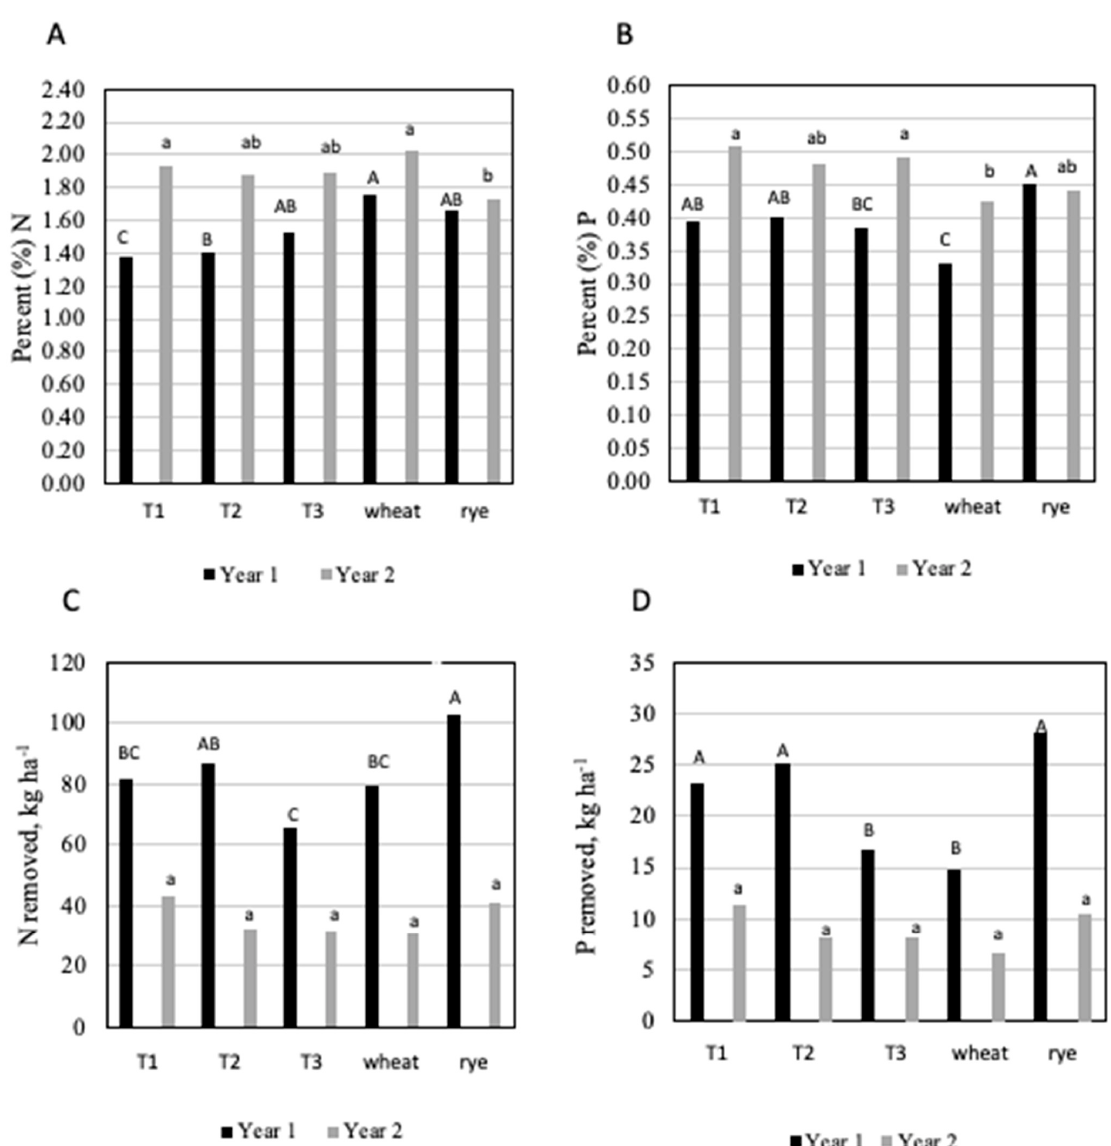
Figure 3. ( A ) Percent N of DPCCs in each experimental year. ( B ) Percent of P of each crop in each experimental year. ( C ) N removed by DPCCs in each experimental year. ( D ) P removed by DPCCs in each experimental year. Means separated by Tukey’s HSD range test. Within the same row, values followed by different letters are statistically different. Uppercase letters are associated with values in year 1; lowercase letters are associated with values in year 2.